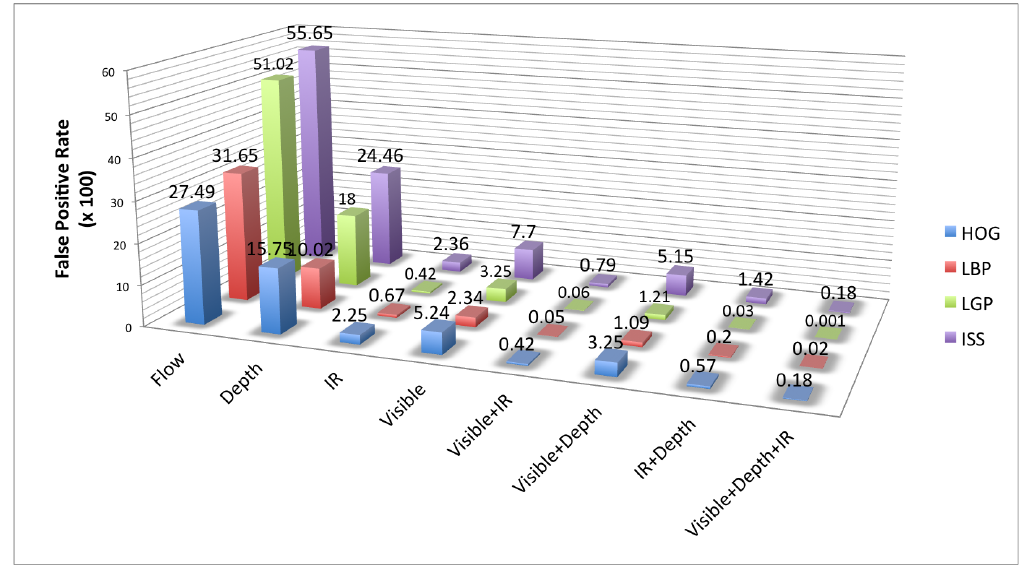
Figure 12. Results overview for the Parma-Tetravision